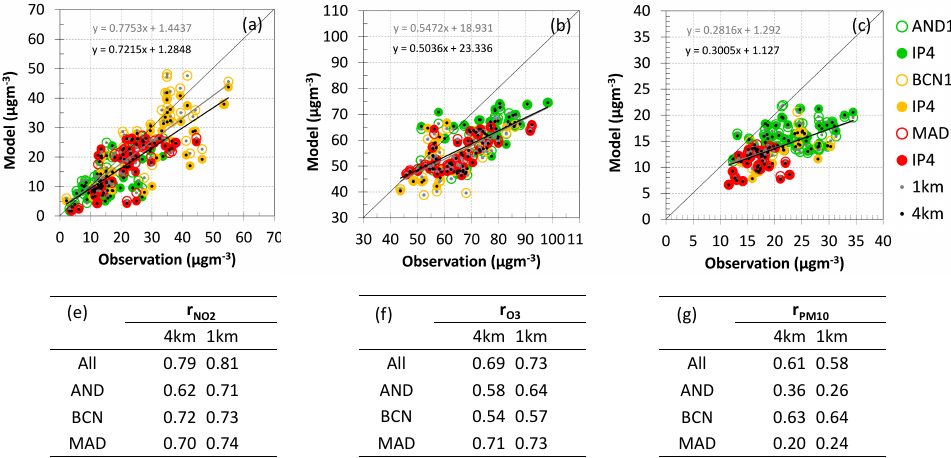
Figure 6. Monthly mean scatter plots for CALIOPE-AQFS ( y axis) and observed ( x axis) concentrations for the three study domains (AND in green, BCN in yellow, and MAD in red), as functions of horizontal resolution for (a) NO 2 , (b) O 3 and (c) PM 10 . Equations show the linear adjustment between models and observations at 1km (light grey) and 4km (dark grey). Spatial correlation coefficients as a function of resolution and domain are shown for (e) NO 2 , (f) O 3 , and (g) PM 10